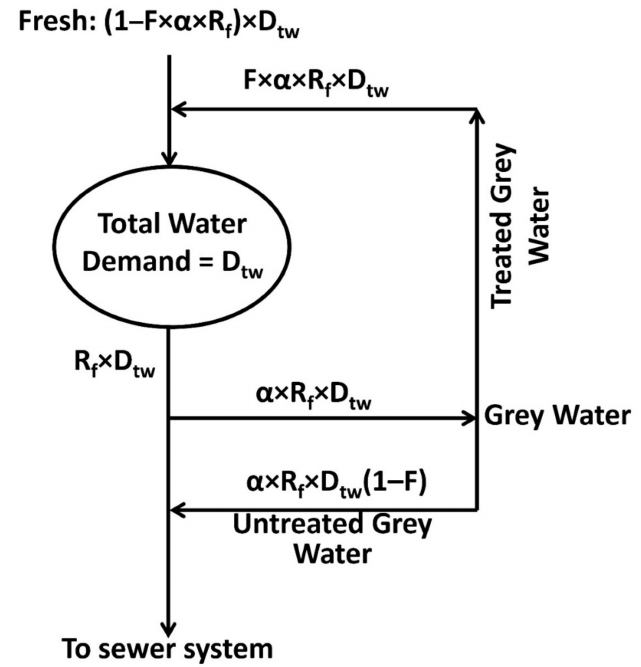
Figure 2. Schematic for mass flow balance at any node